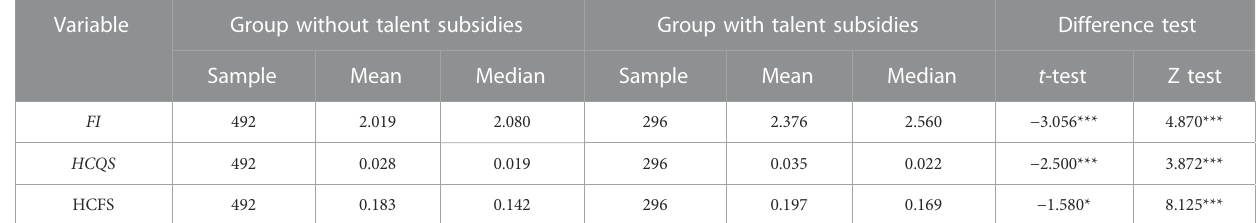
TABLE 3 Difference test of main variables.